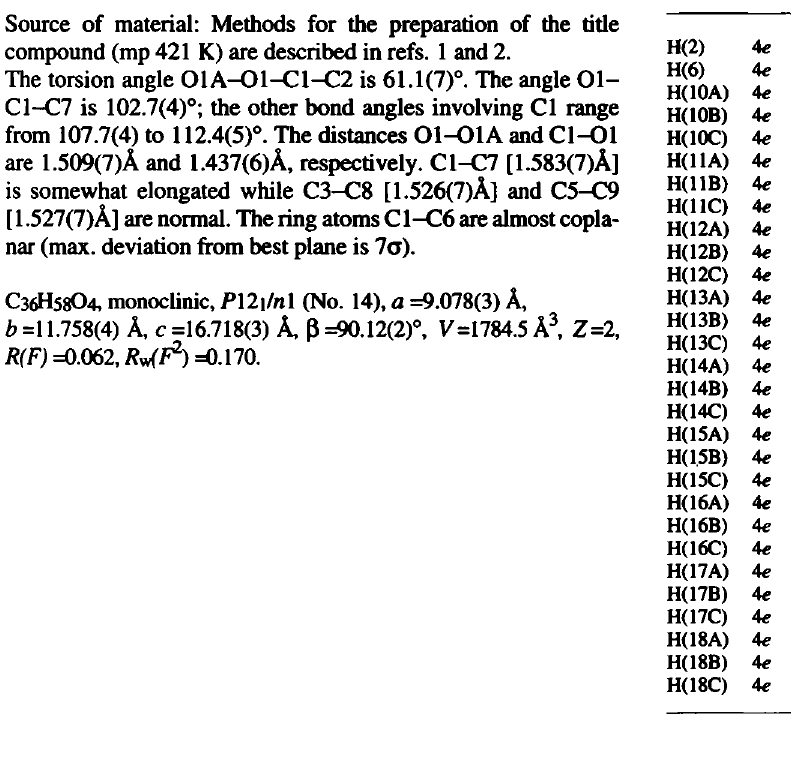
Table 1. Final atomic coordinates and displacement parameters (in Â 2